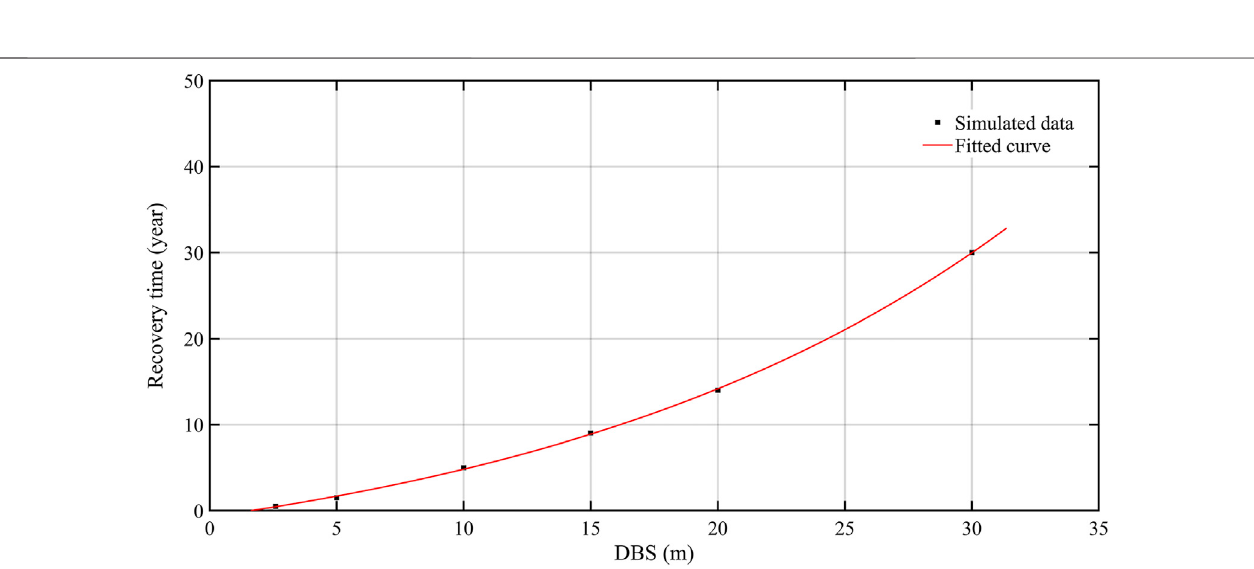
FIGURE 9 | Regression relationship between the depths of back fi ll soils (DBS) and the recovery time of ground temperature.